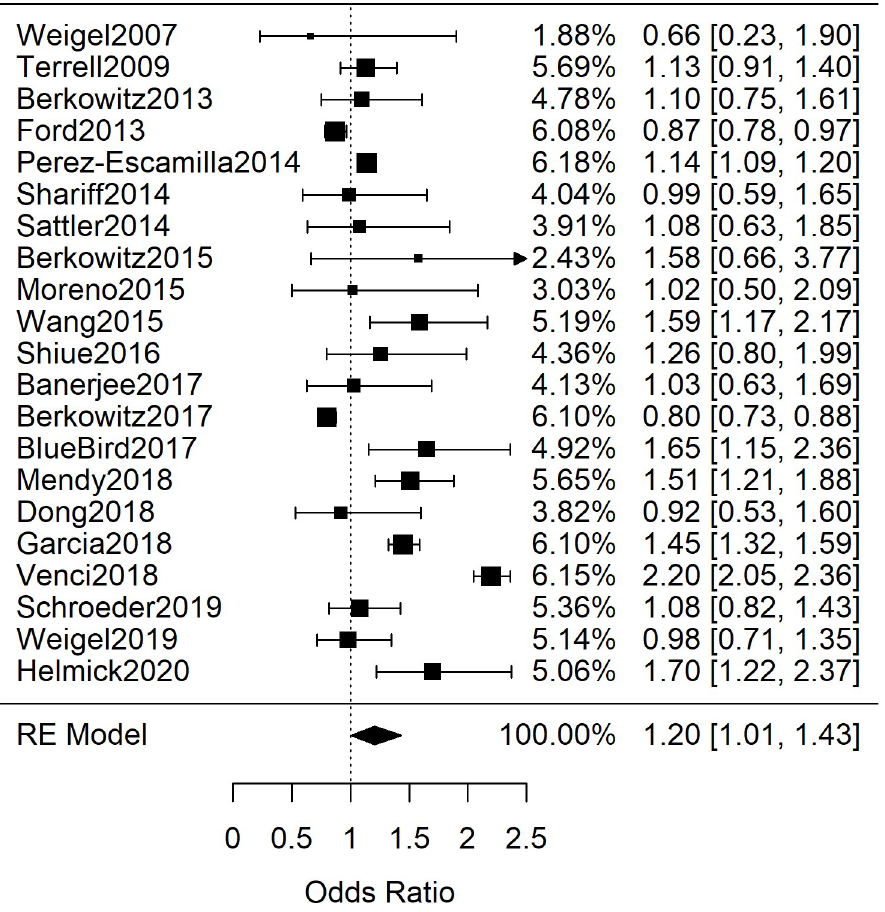
between study effect sizes and a significant, combined odds ratio of 1.20 [95%CI: 1.01, 1.43; n = 190,429; Q ( df = 20) = 426; I 2 =